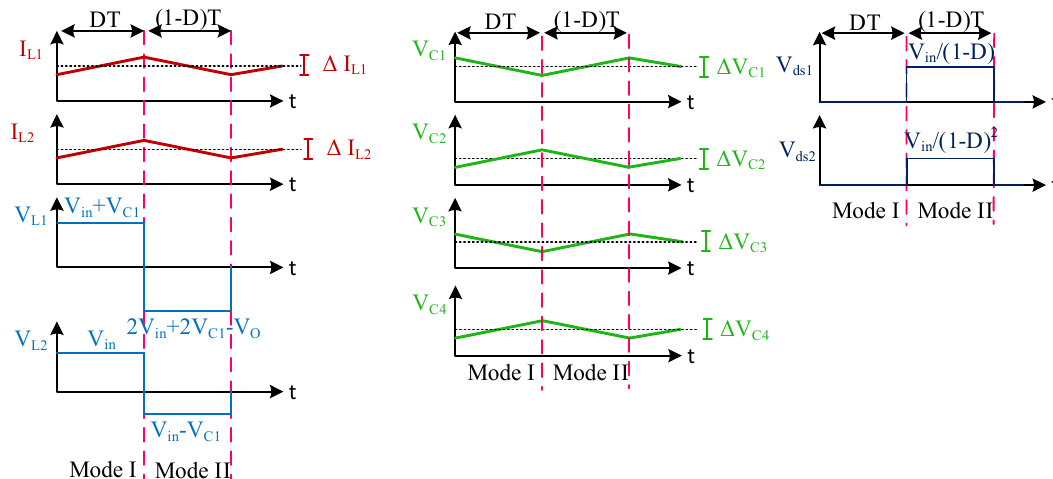
Figure 3. Related waveforms in continuous conduction mode (CCM).